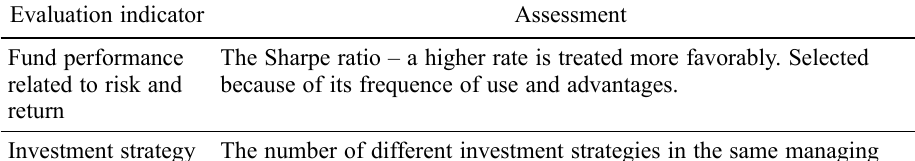
Table 1. General evaluation indicators of 3 rd pillar PF and their assessment Evaluation